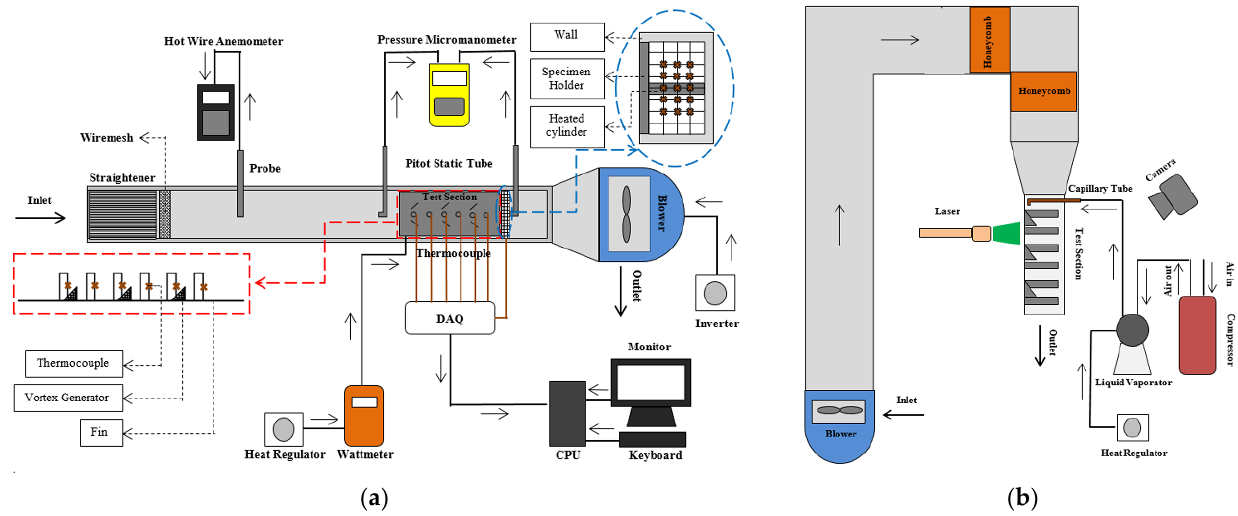
Figure 1. ( a ) Schematic of heat transfer rate and pressure drop test equipment; ( b ) flow visualization experimental set-up.